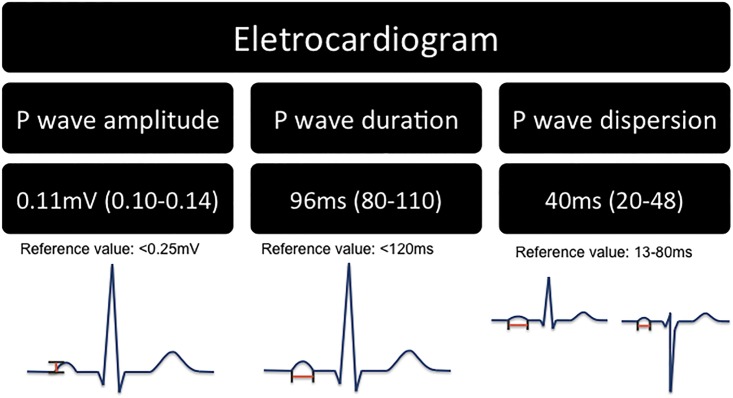
P-wave measurements and reference values.